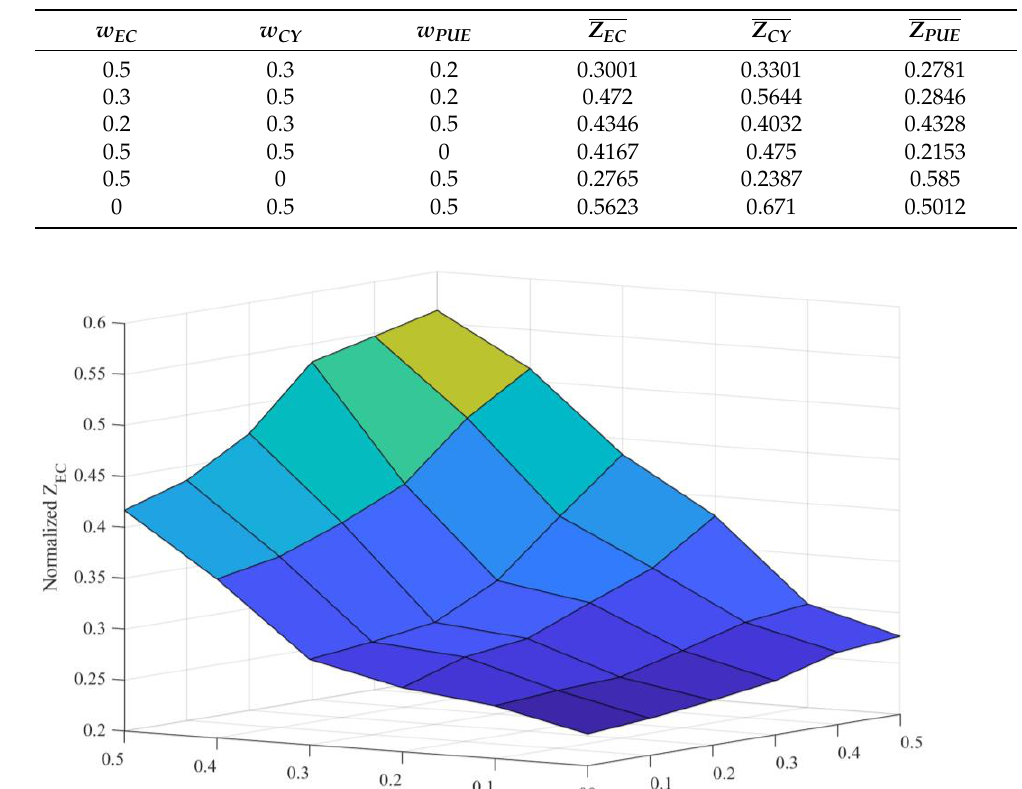
Figure 10. Comparison of the worst, mean, and best results, obtained by different methods.